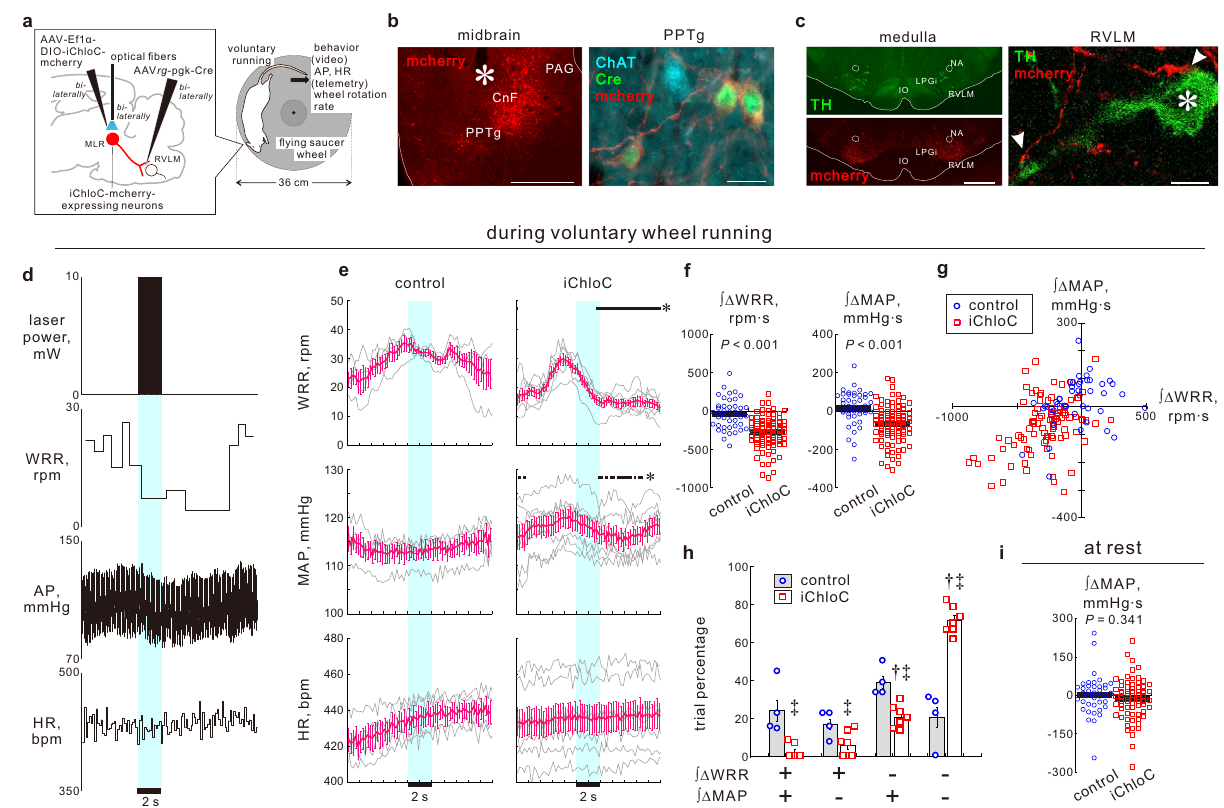
Fig. 5 | MLR → RVLM pathway mediates both locomotor activities and cardio- vascularresponsesduringvoluntaryrunningexercise.a Optogeneticinhibition ofMLR → RVLMneuronsofconsciousratsfreetomoveinacagecontaininga fl ying saucer wheel. b Cre-dependent iChloC-mCherry expression in MLR → RVLM neu- rons. Asterisk: optic- fi ber tip location. Scale bars: 1mm (left); 20 μ m (right). c Distribution of mCherry-immunoreactive axons in the medulla (left); swellings were closely opposed to RVLM C1 neuronal dendrites and cell bodies (asterisks; right).Scalebars:1mm(left);10 μ m(right). d Representativelocomotorspeedand cardiovascular changes in response to 2-s optogenetic inhibition during wheel running in an iChloC-mcherry-expressing rat. WRR, wheel rotation rate. The over- head view during recording is reported in Supplementary Movie 3. e Time course (200-ms bins) changes in response to 2-s optogenetic intervention during running in eYFP-expressing controls ( n =4) and iChloC-mCherry-expressing male rats ( n =7). Gray, individual data averaged over trials. f Comparisons between controls (45 trials/4 rats) and iChloC-mCherry-expressing rats (96 trials/7 rats): integrated Δ WRR and Δ MAP for 5s after the onset of 2-s optogenetic intervention during running. Pre-illumination level was determined as a mean value during the 2-s periodimmediatelypriortolaserillumination.Horizontalbars,meanvalues. g Plots